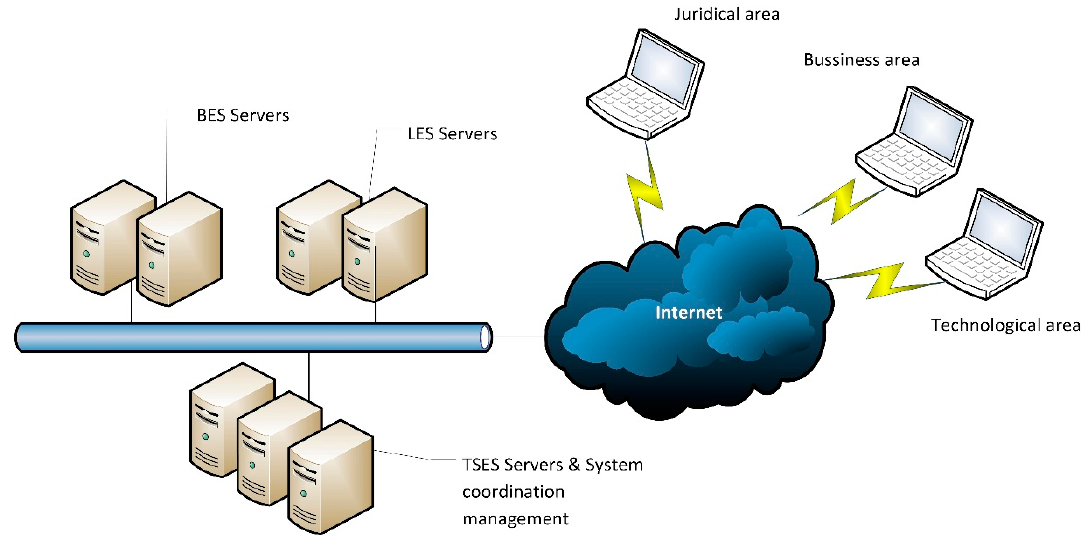
Figure 9. Working network.